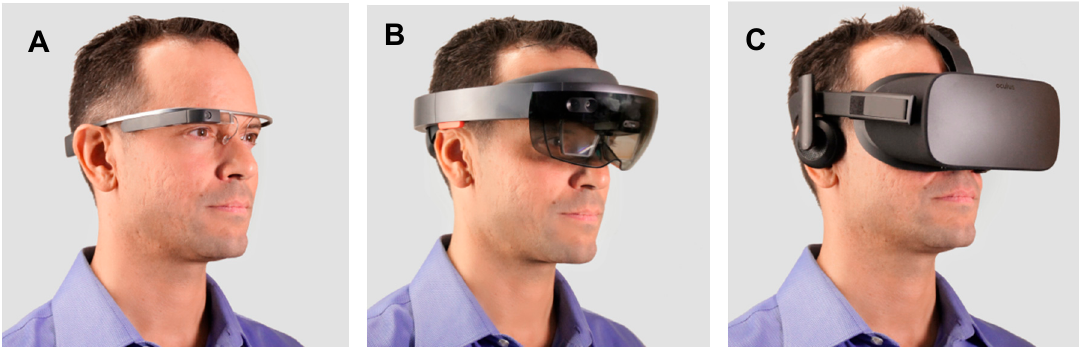
Figure 1. Head-worn Computers or Displays Vary in Size, Weight, and Face-Obstruction. ( A )